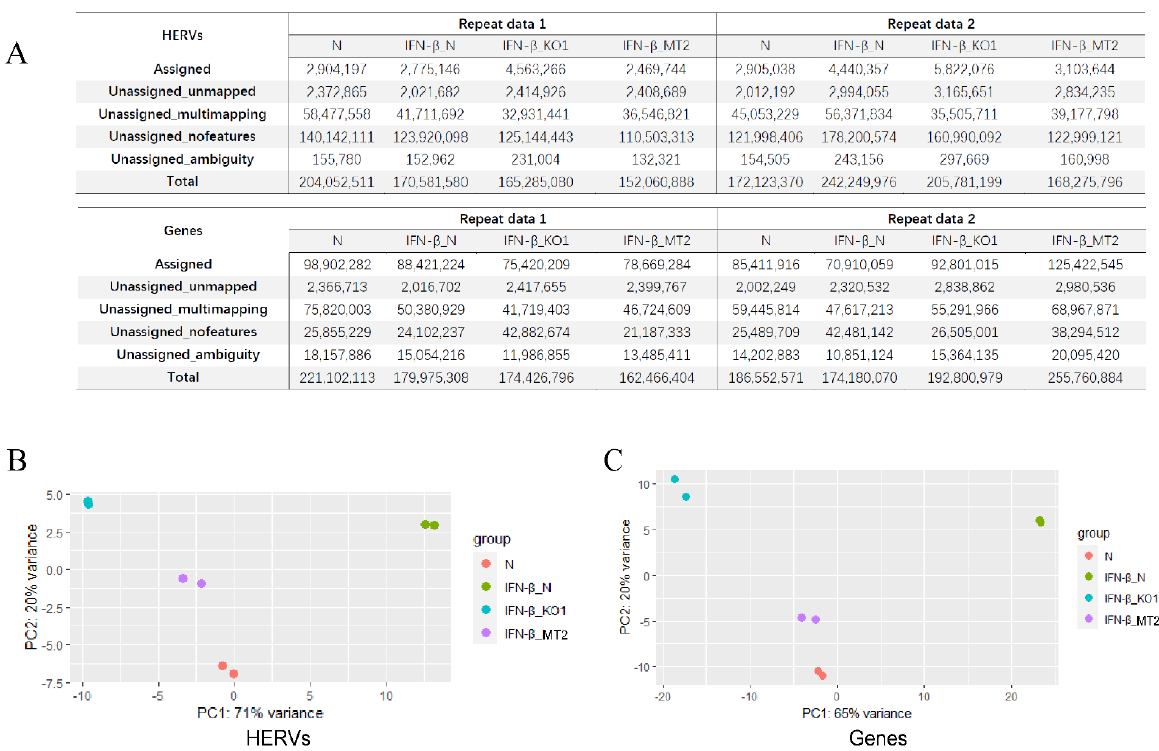
Figure 1. Clean reads acquired and PCA analysis. ( A ) Clean reads of HERVs and genes mapped on the reference genome, including four datasets with two duplicates: IFN- β -treated THP1 cells (IFN- β _N), IFN- β -treated THP1_IFNAR1_KO cells (IFN- β _KO1), IFN- β -treated THP1_IFNAR2_mutant cells (IFN- β _MT2), and the untreated THP1 cells (N). PCA analysis of the transformed expression values of HERV loci ( B ) and human genes ( C ).